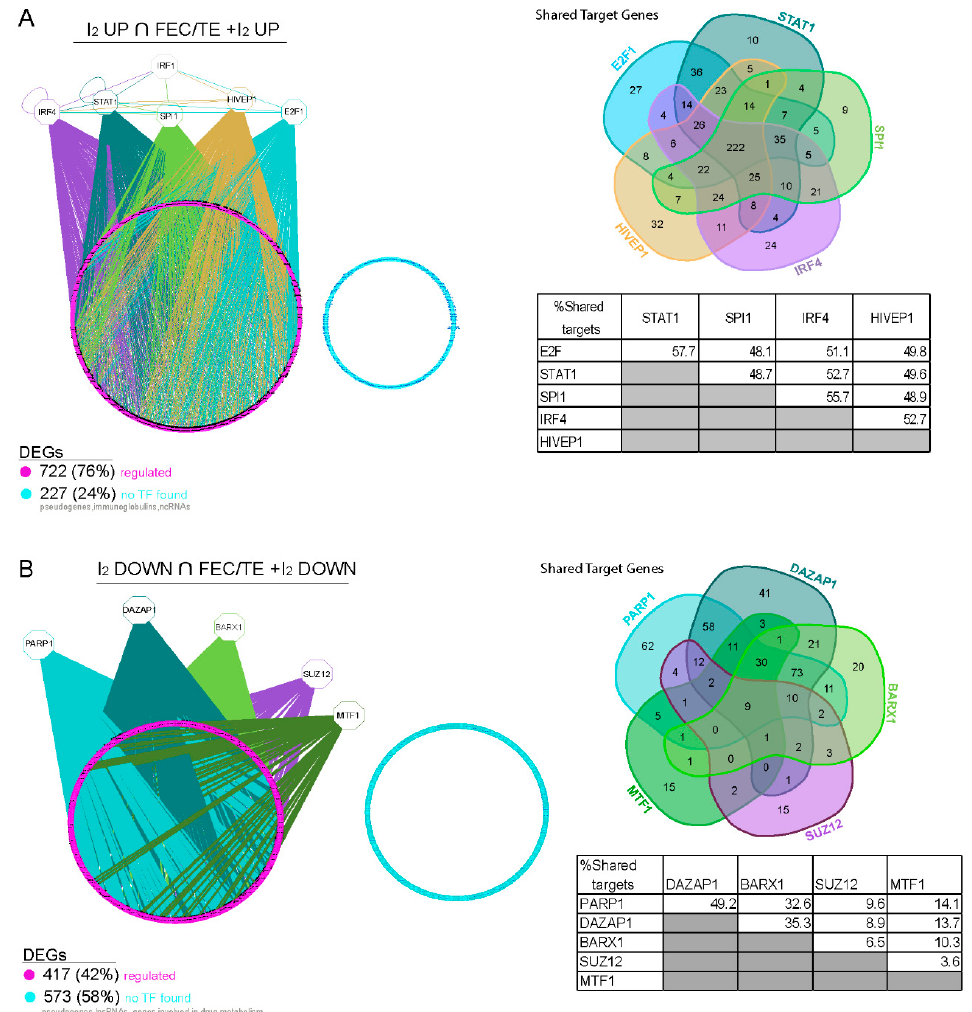
Figure 7. Master regulators involved in I 2 treatment-related gene regulatory networks. ( A ) The main candidate transcription factors predicted to regulate genes found upregulated following I 2 or FEC / TE + I 2 treatment. ( B ) The main candidate transcription factors predicted to regulate genes found downregulated following I 2 or FEC / TE + I 2 treatment. For both panels: Left, iRegulon predicted gene regulatory network. The predicted target genes are shown in pink, whereas genes for which no transcription factor regulator was identified are shown in blue. Right, Venn diagram and diagram of shared target genes between the main transcription factors identified. The identified transcription factors have a maximum FDR on motif similarity of 0.001. Di ff erentially expressed genes (DEGs) are defined as having an FDR < 0.05 and |log fold change (FC)| > 1).